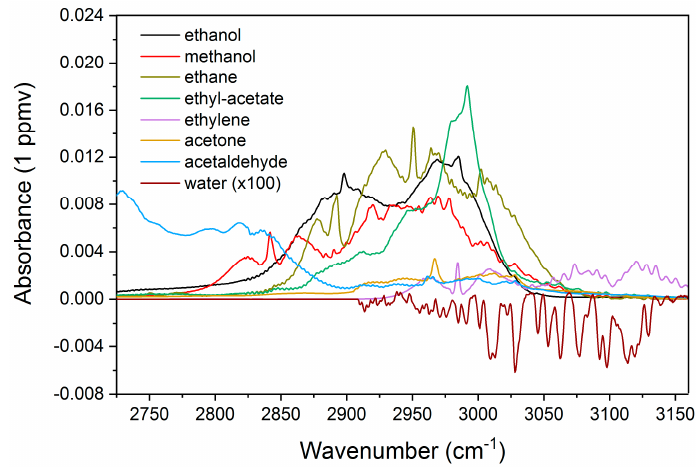
Figure 4. The reference absorbance (base-10) database at 1 ppmv level, including the targeted gas species. Note that water absorbance is inverted and re-scaled for clarity.